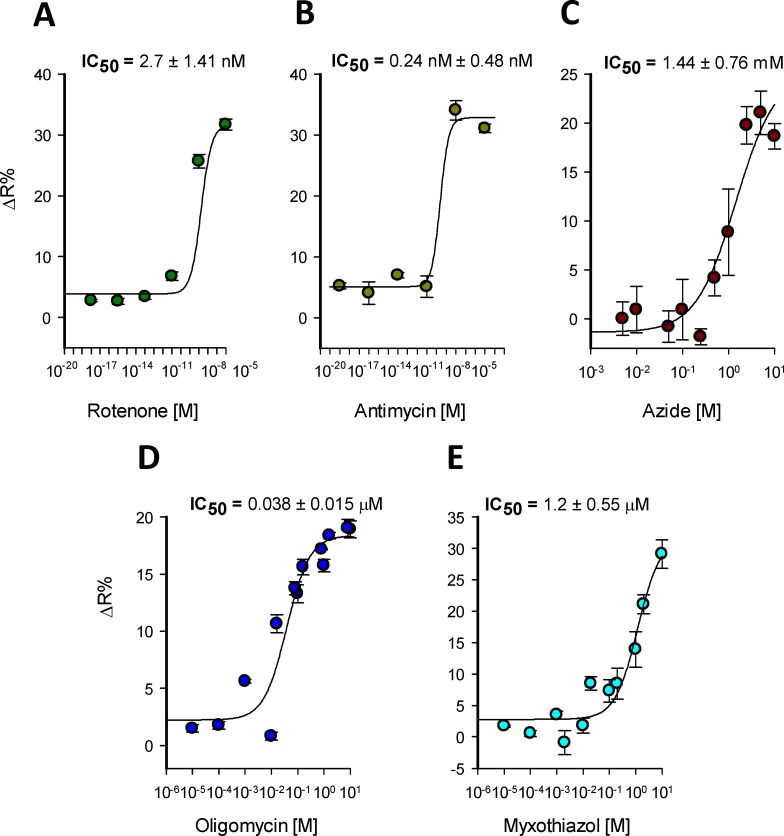
IC50 for classical mitochondrial toxicants.Dose-response Lactate accumulation induced by classical mitochondrial toxicants was measured at: A) 10xE10-5, 10xE10-8, 10xE10-11, 10xE10-14, 10xE10-17 and 10xE10-20 in molar of rotenone and B) antimycin C) 10, 5, 2.5, 1, 0.5, 0.25, 0.1, 0.05, 0.01 and 0.005 in mM of azide D) 16, 10, 8, oligomycin and E) 10, 2, 1, 0.2, 0.1, 0.02, 0.01, 0.002, 0.001, 0.0001 and 0.00001 in μM of myxothiazol. Data was collected at 10 minutes after toxicant treatment at 37°C. Data is the average from three independent experiments.